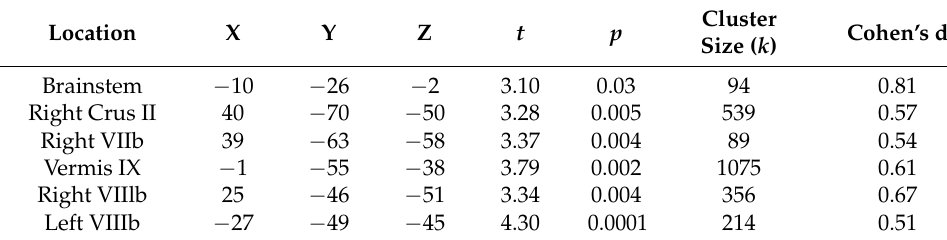
Table 4. MNI coordinates for significant positive association between Performance Quality Rating Scale (PQRS) scores and gray matter volume following CO-OP intervention in children with DCD.